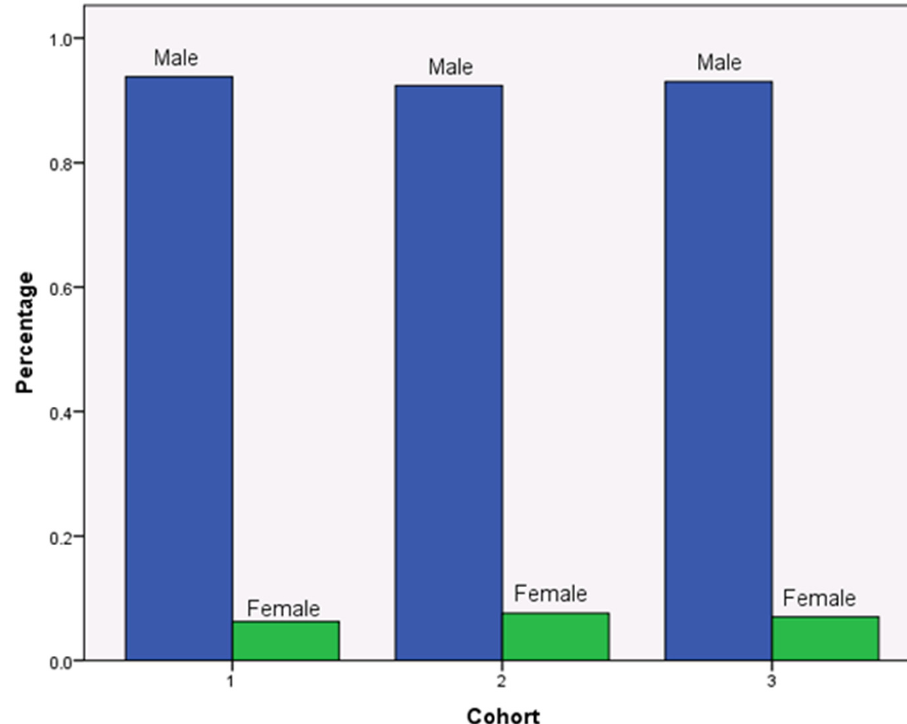
Figure 1. Randomness of Age Distribution.